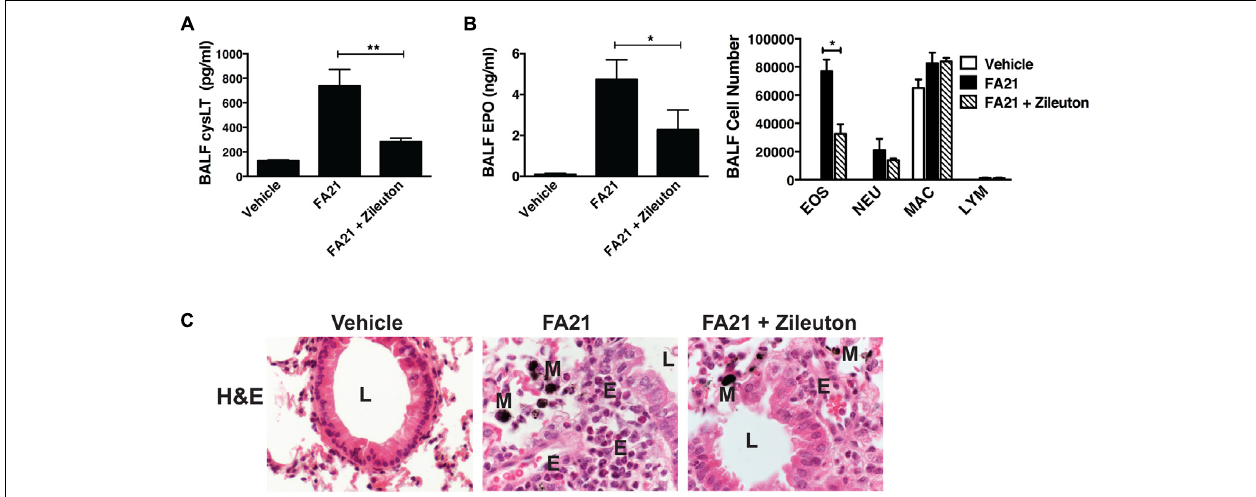
FIGURE 4 | Pharmacological inhibition of cysLT biosynthesis using a 5-lipoxygenase inhibitor caused a reduction in MWCNT-induced pulmonary eosinophilic inflammation. To examine whether cysLTs contributed to FA21 MWCNT-induced inflammation, C57BL/6 mice (six per group) were treated with either Zileuton (10 mg/Kg) or vehicle by oropharyngeal instillation 3 h before administration of FA21 MWCNT (50 µ g intratracheally). Controls comprised of mice treated with carrier alone. BALF and lung tissue was collected 24 h after MWCNT exposure. (A) The level of cysLT in the BALF was evaluated using ELISA. (B) BALF cell-associated eosinophil peroxidase (EPO) activity was assessed by colorimetric assay. Cell differential counts were determined and expressed as absolute cell numbers per mouse of eosinophils (EOS), polymorphonuclear neutrophils (NEU), macrophages (MAC) and lymphocytes (LYM). Results are mean ± SEM ( n = 6), ∗ p < 0.05 and ∗∗ p < 0.01. (C) Peribronchial inflammation was assessed by histological analysis of lung tissue using H&E staining (60 × ) (E, eosinophils; M, MWCNT aggregates; L, bronchial lumen). Data are representative of three independent